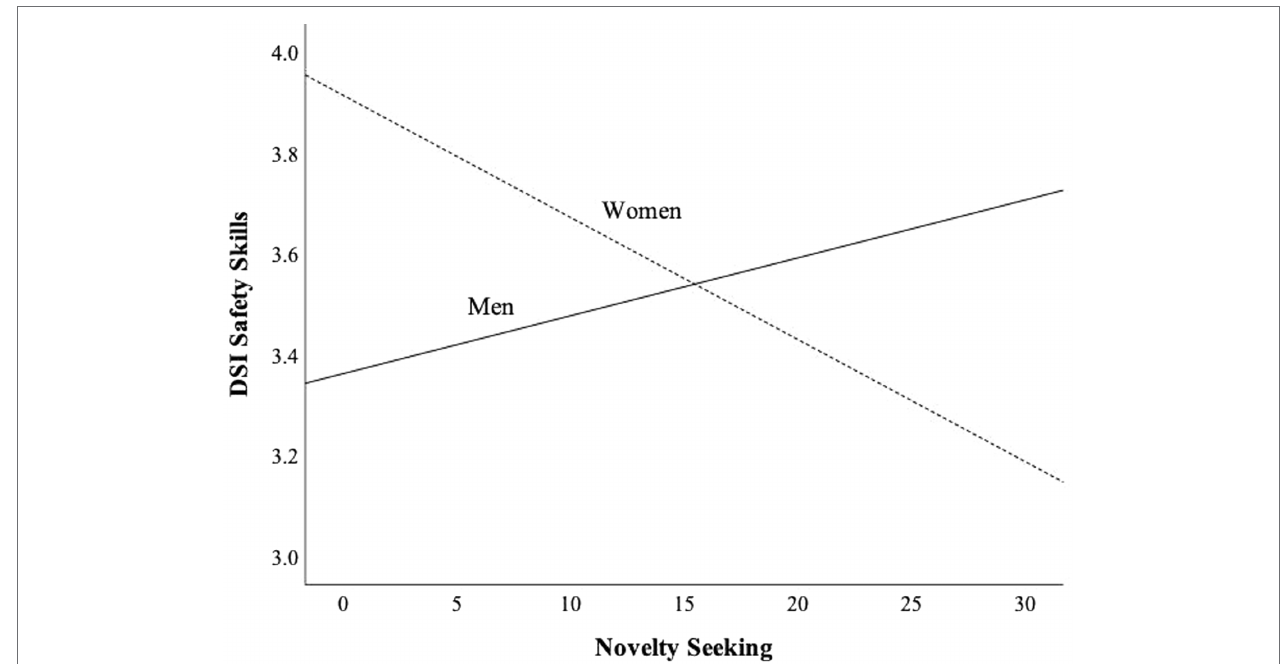
FIGURE 2 | Moderation effect of gender on the relationship between novelty seeking (NS) and safety skills